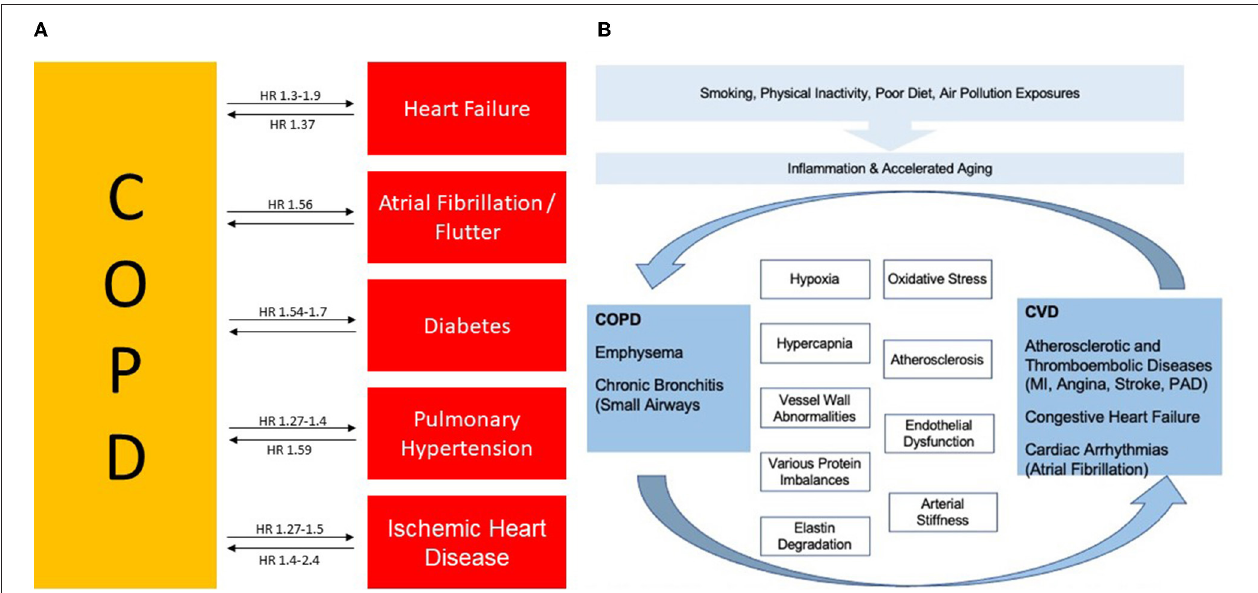
FIGURE 1 | (A) Association between COPD, cardiovascular disease and risk factors and their interrelationship. (B) Both diseases are closely linked for several features. COPD, Chronic Obstructive Pulmonary Disease; CVD, Cardiovascular Disease, HR, Hazard Ratio; MI, Myocardial Infraction; and PAD, Peripheral Arterial Disease. Figure adapted from Rabe et al., (38) and adapted from Morgan et al., (34).